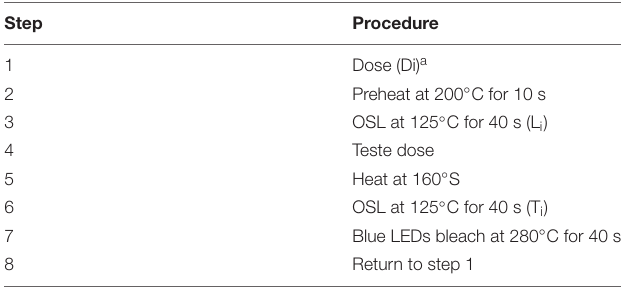
TABLE 1 | SAR-OSL protocol used for equivalent dose estimation of the studied samples, according to Murray and Wintle (2000, 2003).